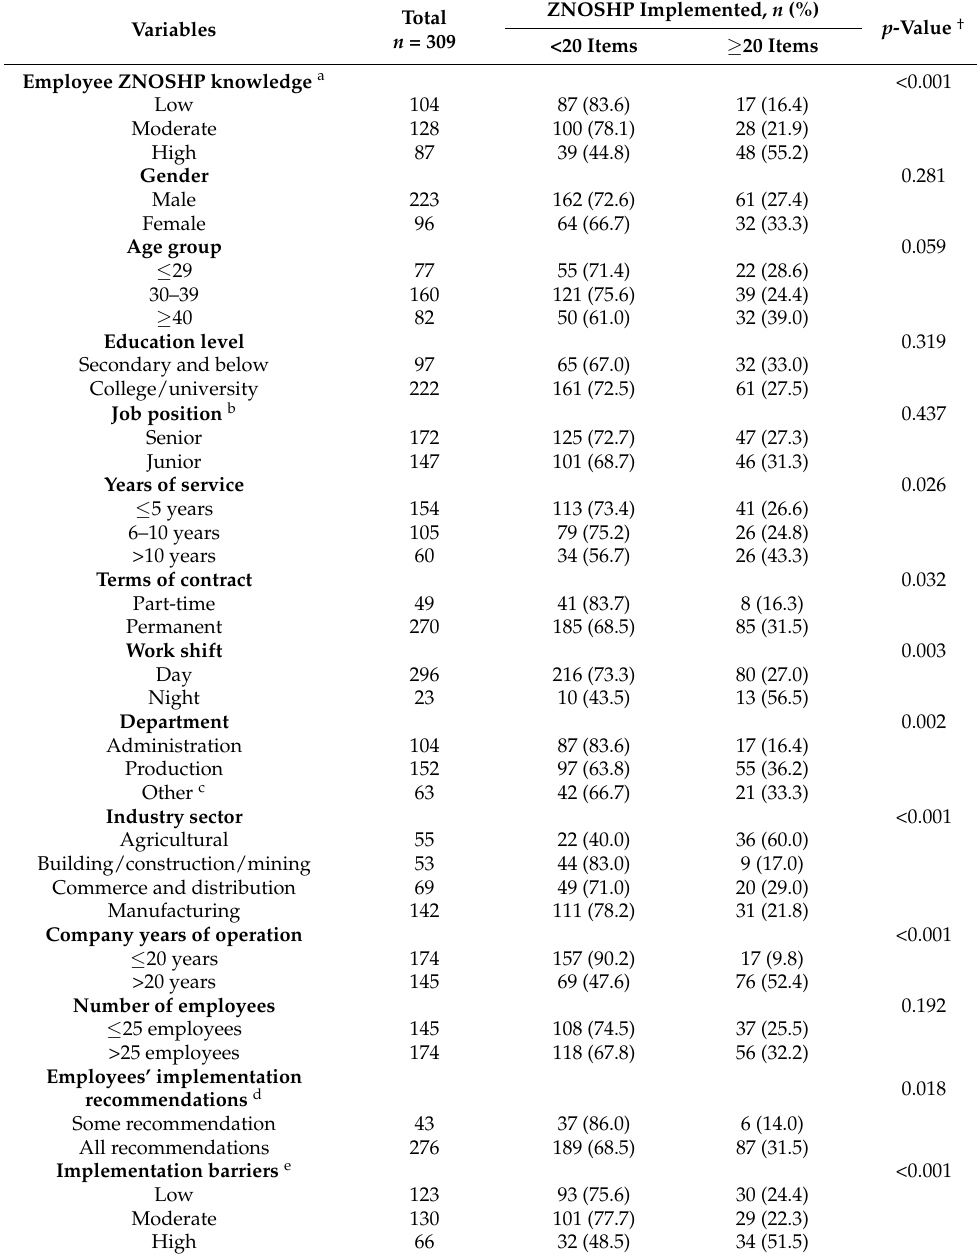
Table 2. Differences between participant characteristics by implementation of the ZNOSHP in Willowvale industrial area,